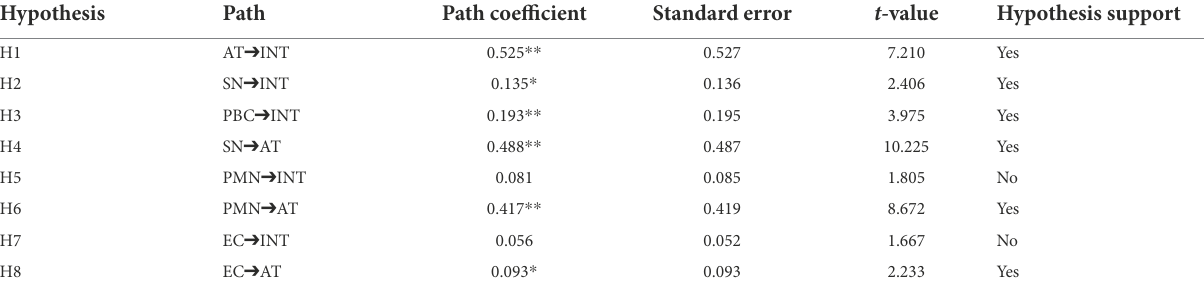
TABLE 4 Results of measurement model